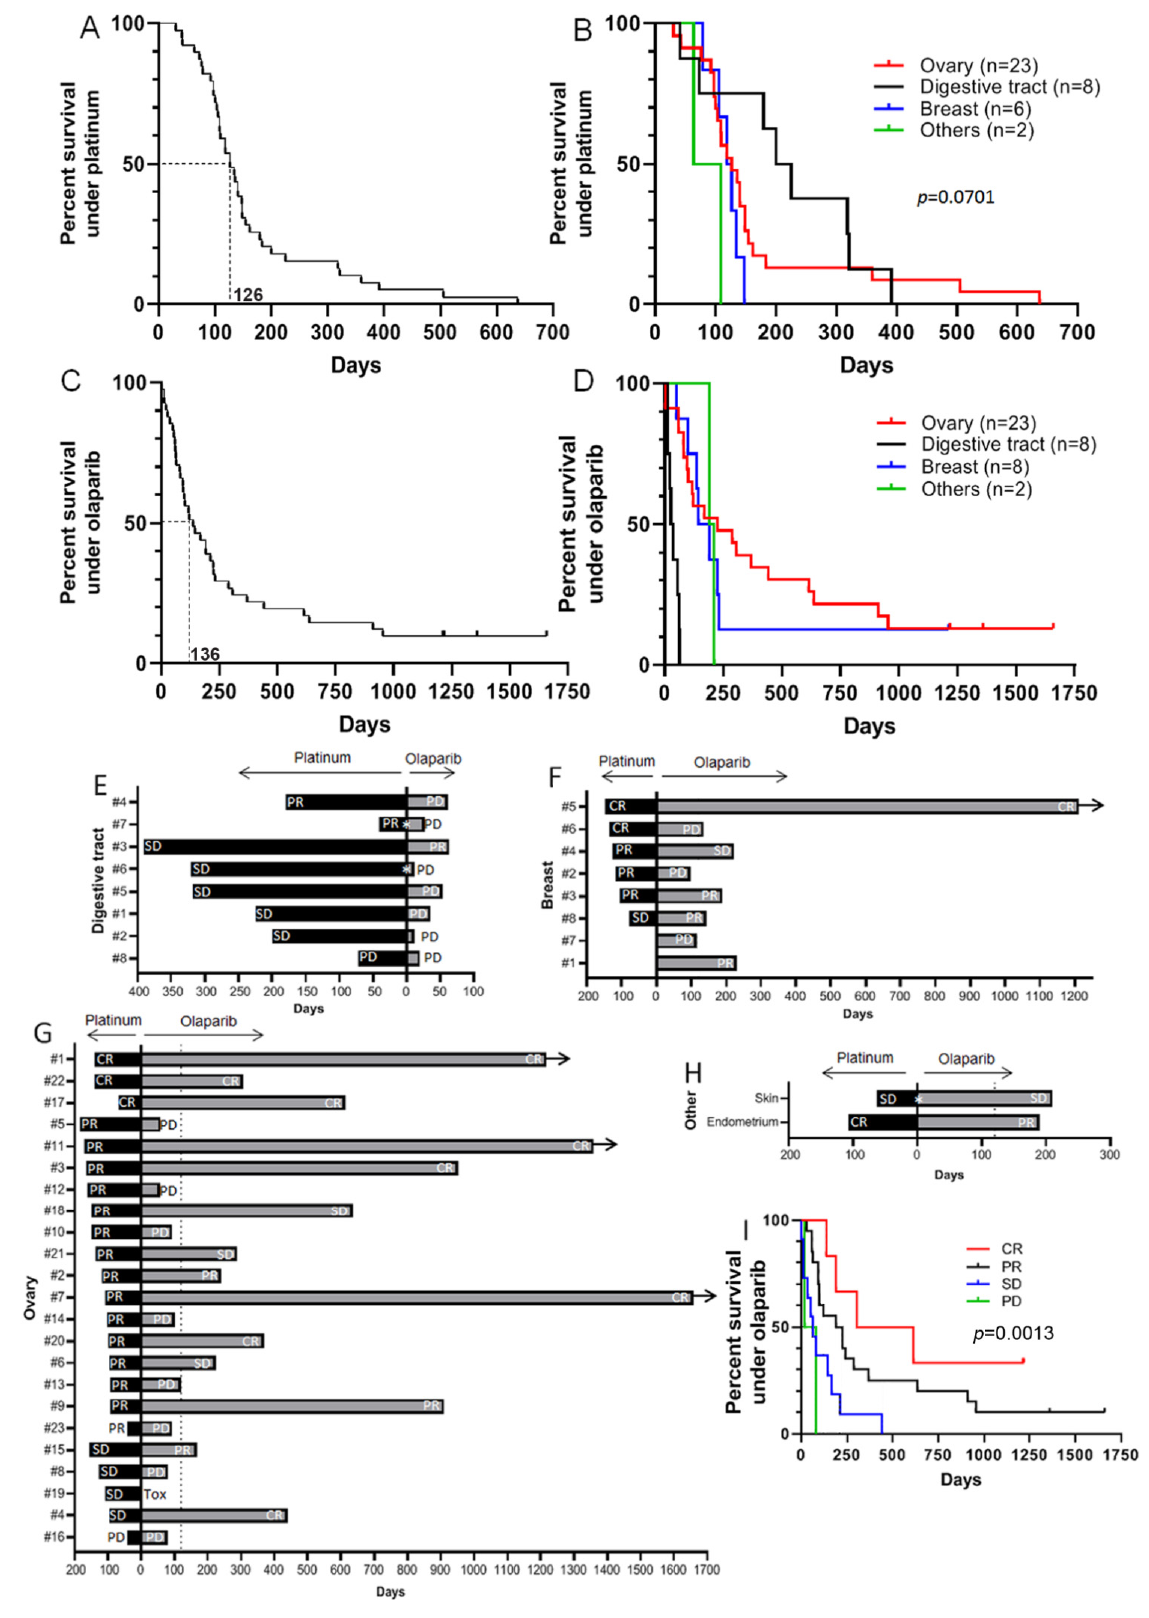
Figure 1. Progression-Free Survival (PFS) of patients in response to platinum salt or the PARP inhibitor olaparib. ( A ): PFS curve for 39 patients having received platinum salt-based treatment (mean PFS = 126 days). ( B ): PFS curve for patients